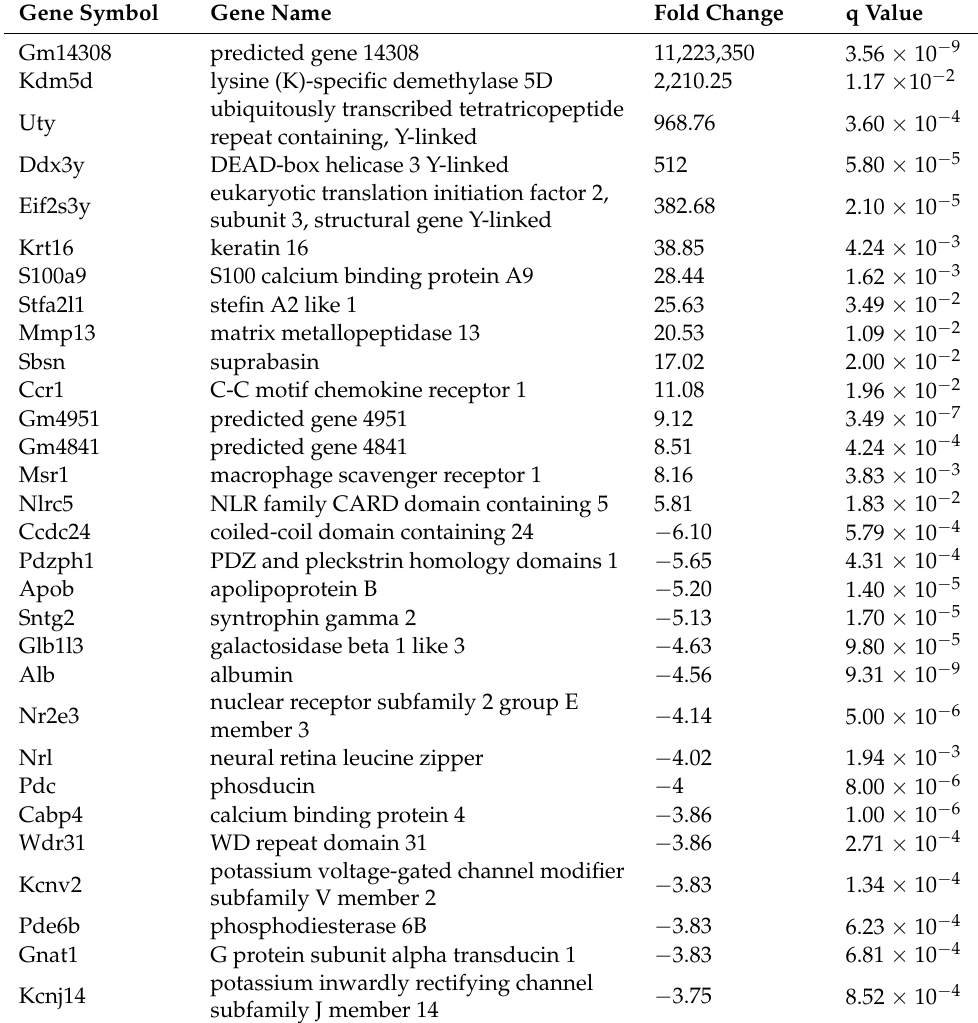
Table 1. Top mRNAs differentially